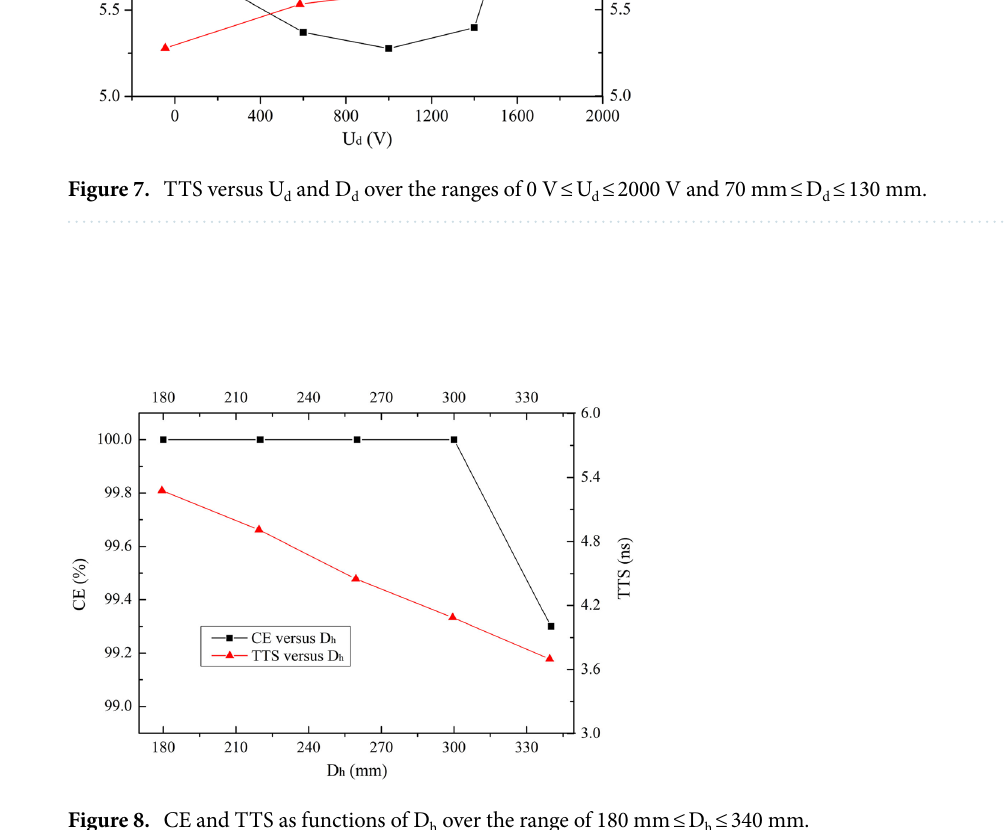
Figure 8. CE and TTS as functions of D h over the range of 180 mm ≤ D h ≤ 340